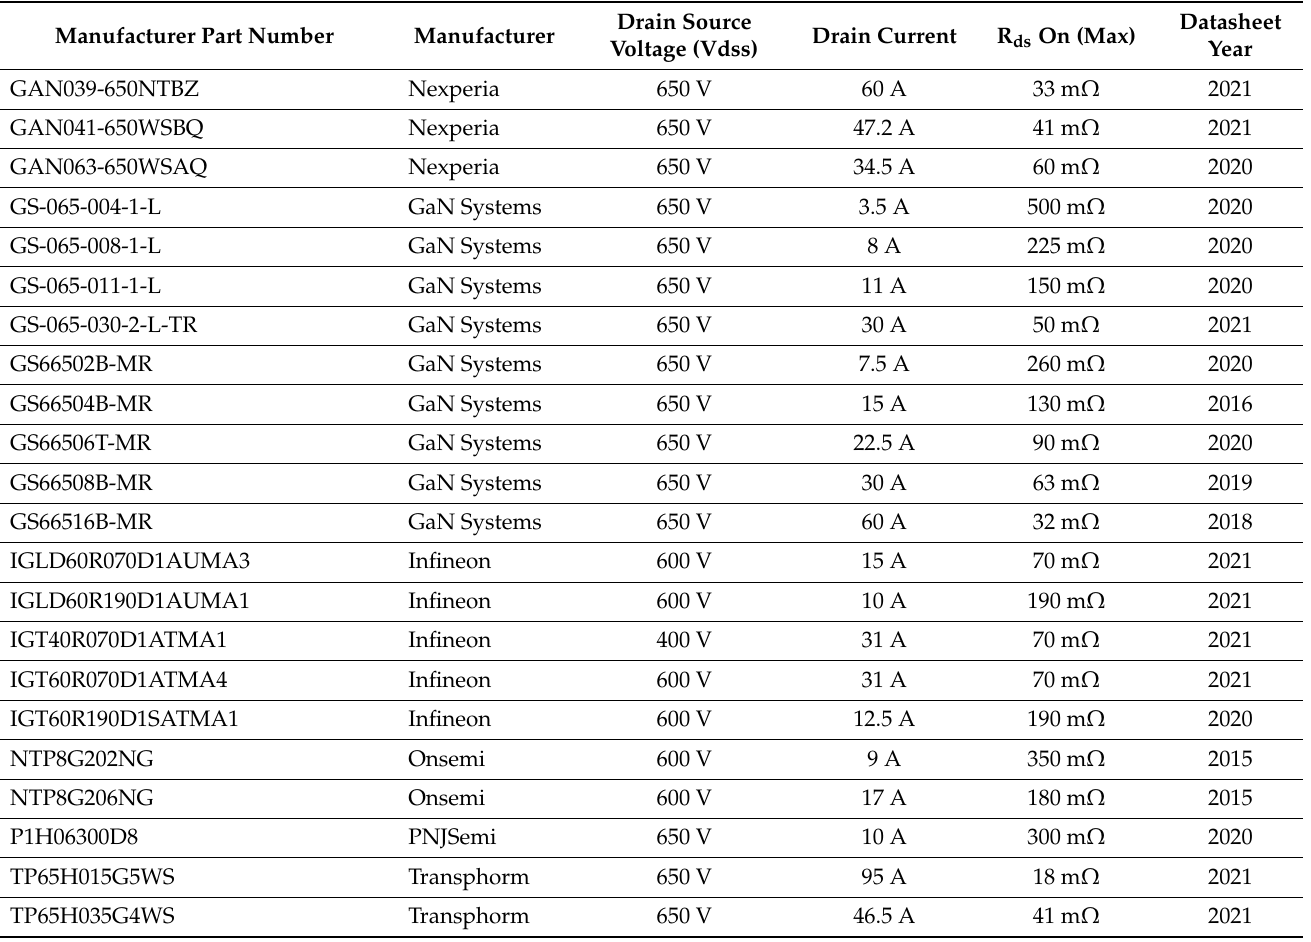
Table 1. List of unique GaN parts (>400 V V dss ) commercially available from major distributors (Digikey, Mouser, Element14, RS Components, LCSC, and